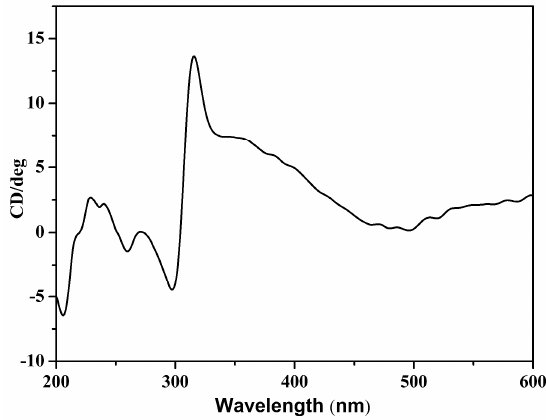
Figure 6. The solid-state circular dichroism (CD) spectra of JUC-112.